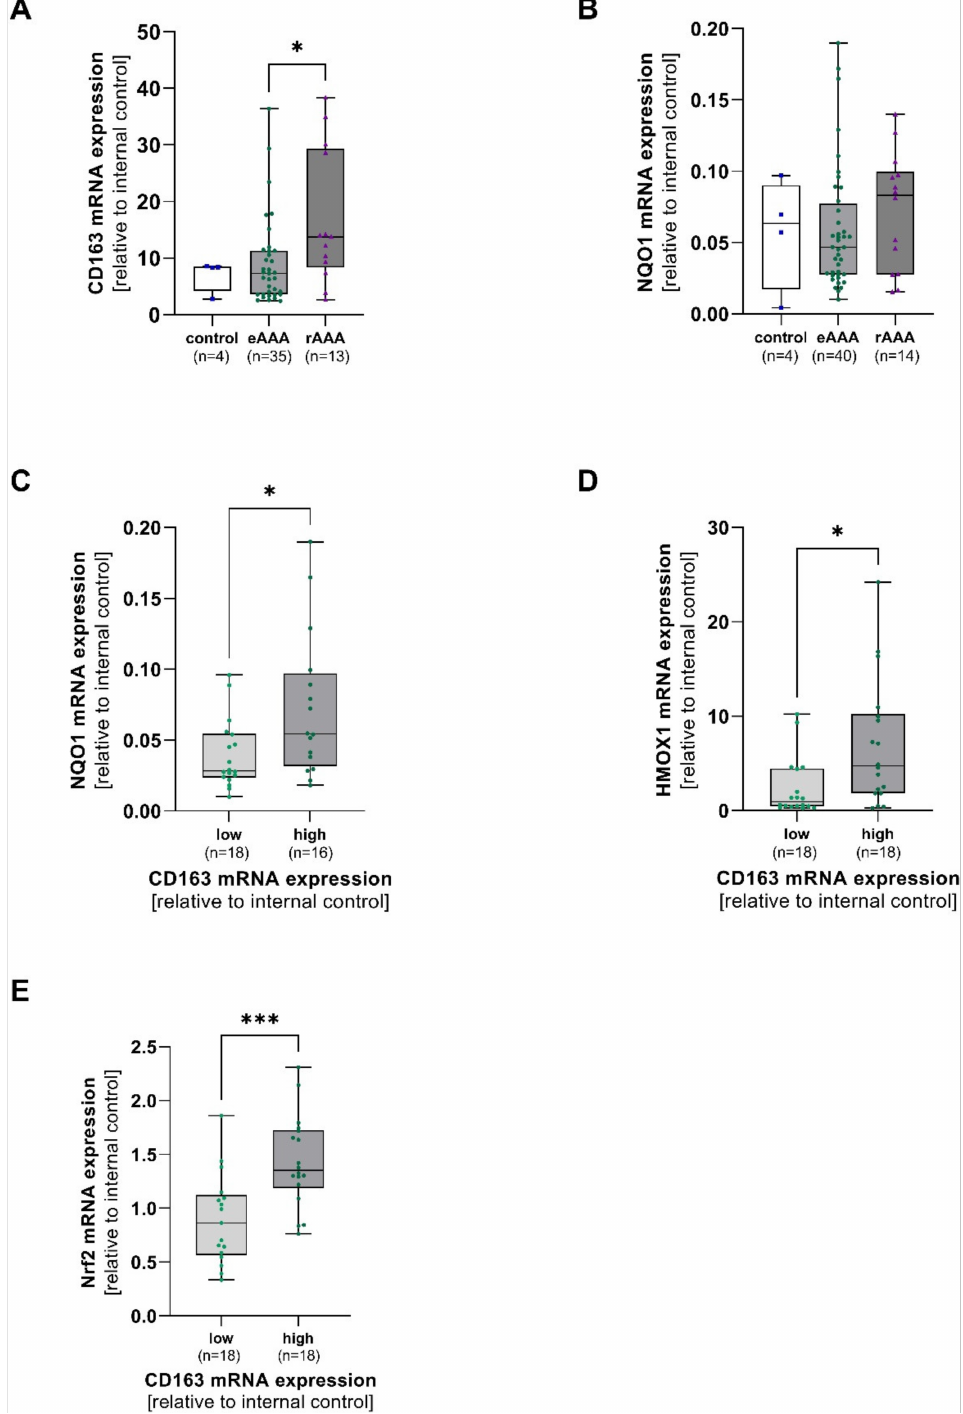
Figure 1. Linkage of aortic CD163 mRNA expression and antioxidant enzymes in AAA and corre- sponding controls. Aortic mRNA expression of CD163, NAD(P)H quinone dehydrogenase 1 (NQO1), heme oxygenase-1 (HMOX1), and nuclear factor erythroid 2-related factor 2 (Nrf2) was analyzed